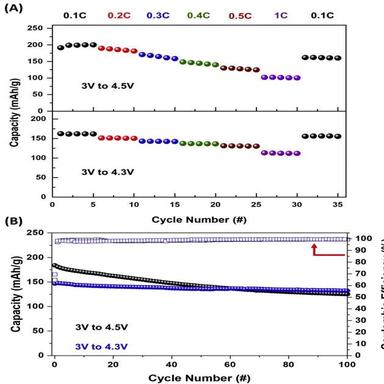
Electrochemical performance evaluation of the NFA cathode material: (A) Rate performance tests (B) Galvanostatic charge/discharge cycling tests at C/3.